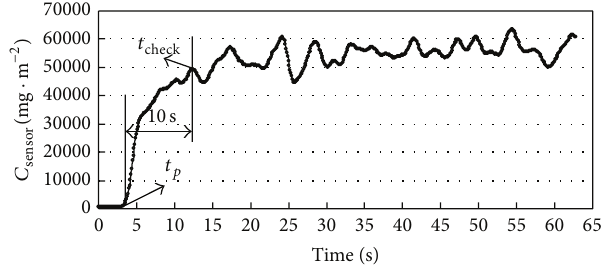
Figure 7: Experimental device photo of 2D space. Figure 8: Measured CO 2 concentration